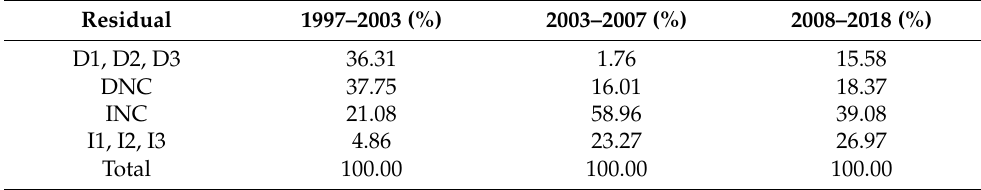
Figure 8. Residual trend graphs of different types of ecosystems for three time-series: 1997–2003, 2003–2007, and 2008–2018. Table 2. Proportions of residual trends for each sub-period in the study